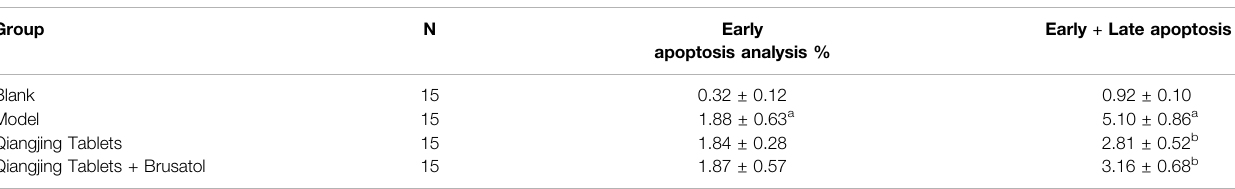
TABLE 3 | Effects on apoptosis induced by Qiangjing Tablets ( x ± SD). Group N Early